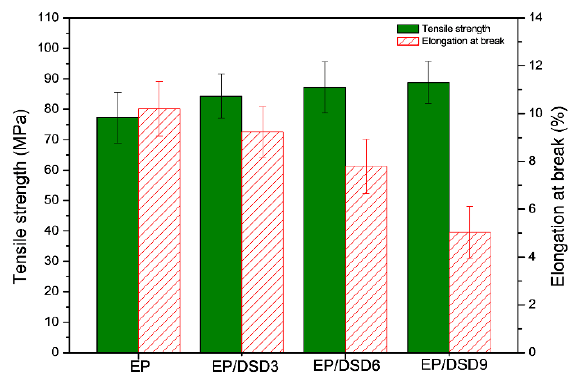
Figure 10. Strength and elongation at the breaking point of epoxy thermosets.